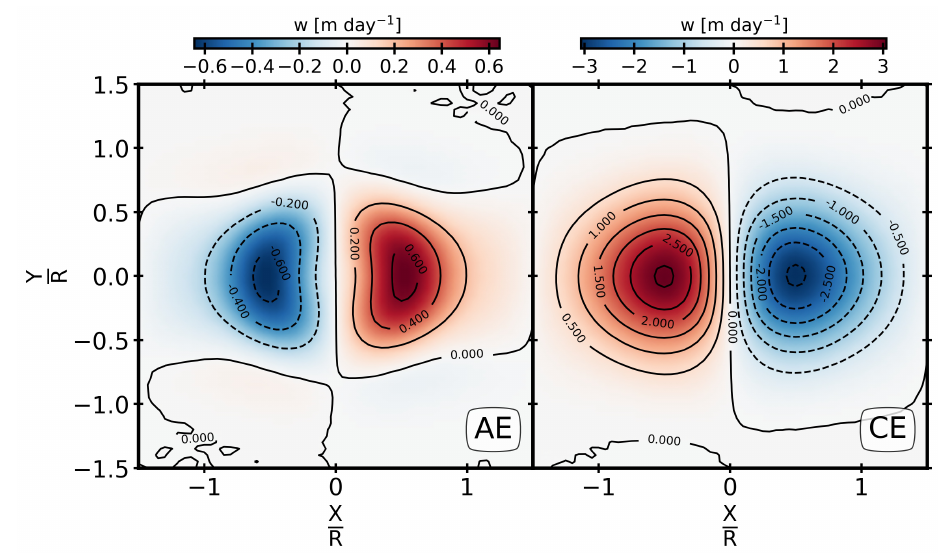
Figure 15. Frontogenesis vertical velocity averaged between the surface and 400 m for the CE and AE. Dashed and solid contours represent negative and positive values with steps of 0.5 for the CE and 0.2 for the